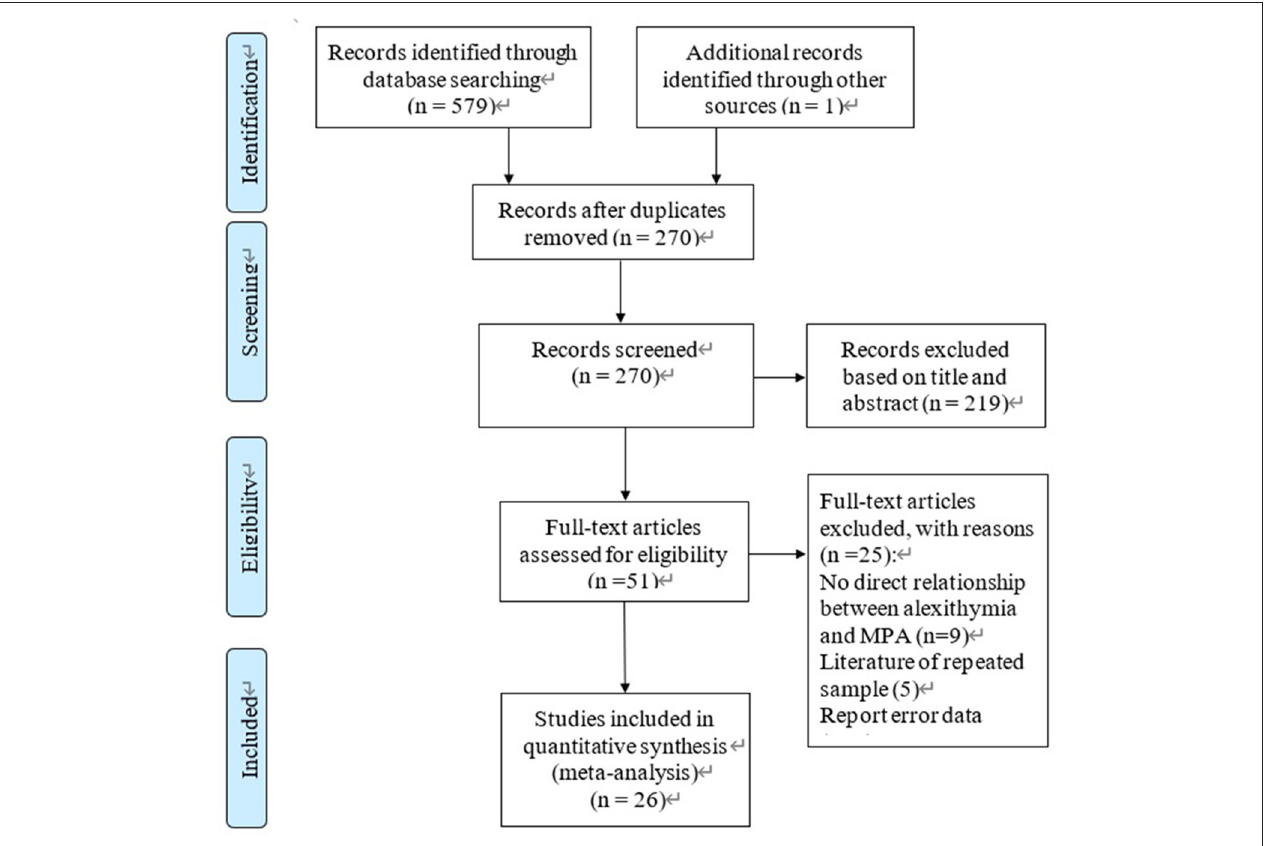
FIGURE 1 | Flow chart of the study selection